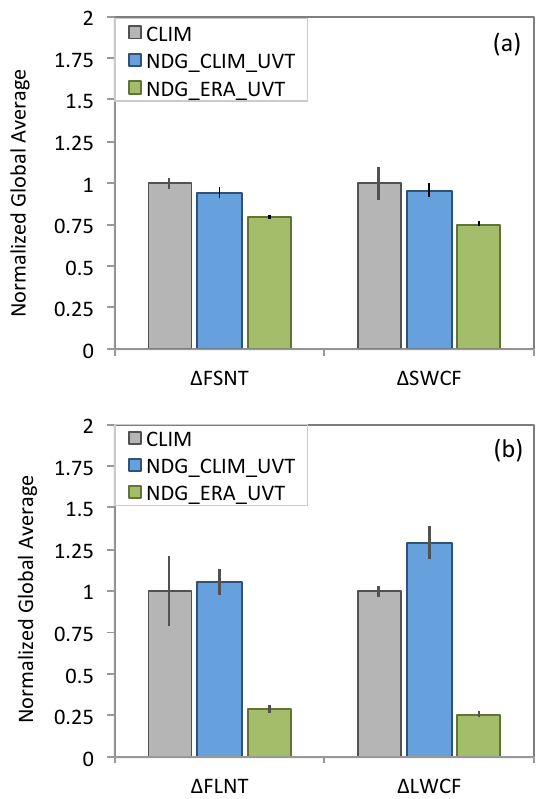
Figure 2. Normalized global mean 5yr mean CAM5 PD–PI dif- ferences ( 1 ) in the (a) TOA net shortwave radiation flux (FSNT) and shortwave cloud forcing (SWCF), and (b) TOA net long-wave radiation flux (FLNT) and long-wave cloud forcing (LWCF). The thin vertical line associated to each bar indicates the standard de- viation of the annual average. Results from the nudges simula- tions (NDG_CLIM_UVT and NDG_ERA_UVT) are normalized by the corresponding 5yr average PD–PI differences from the uncon- strained (CLIM) simulations. Details of the experimental setup are explained in Sect. 2.3 and Table